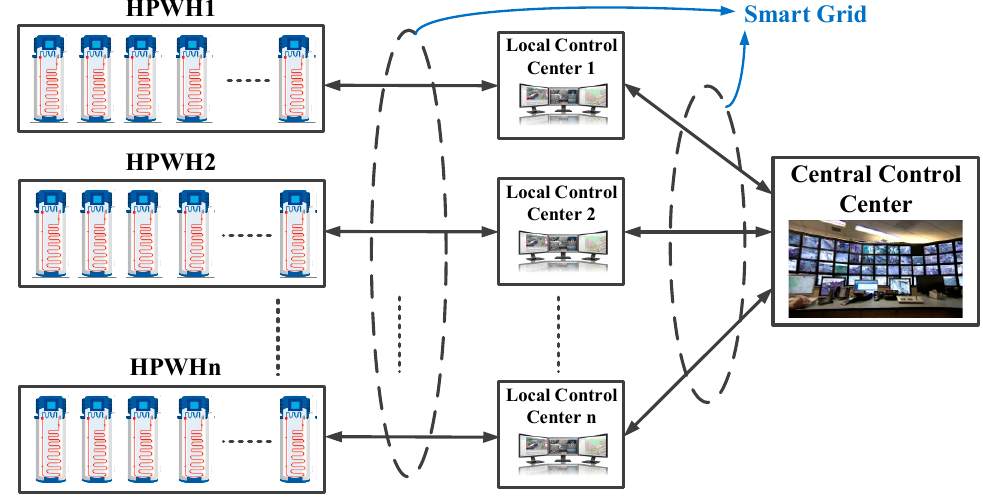
Figure 2. Hierarchical control of heat pump water heater (HPWH).